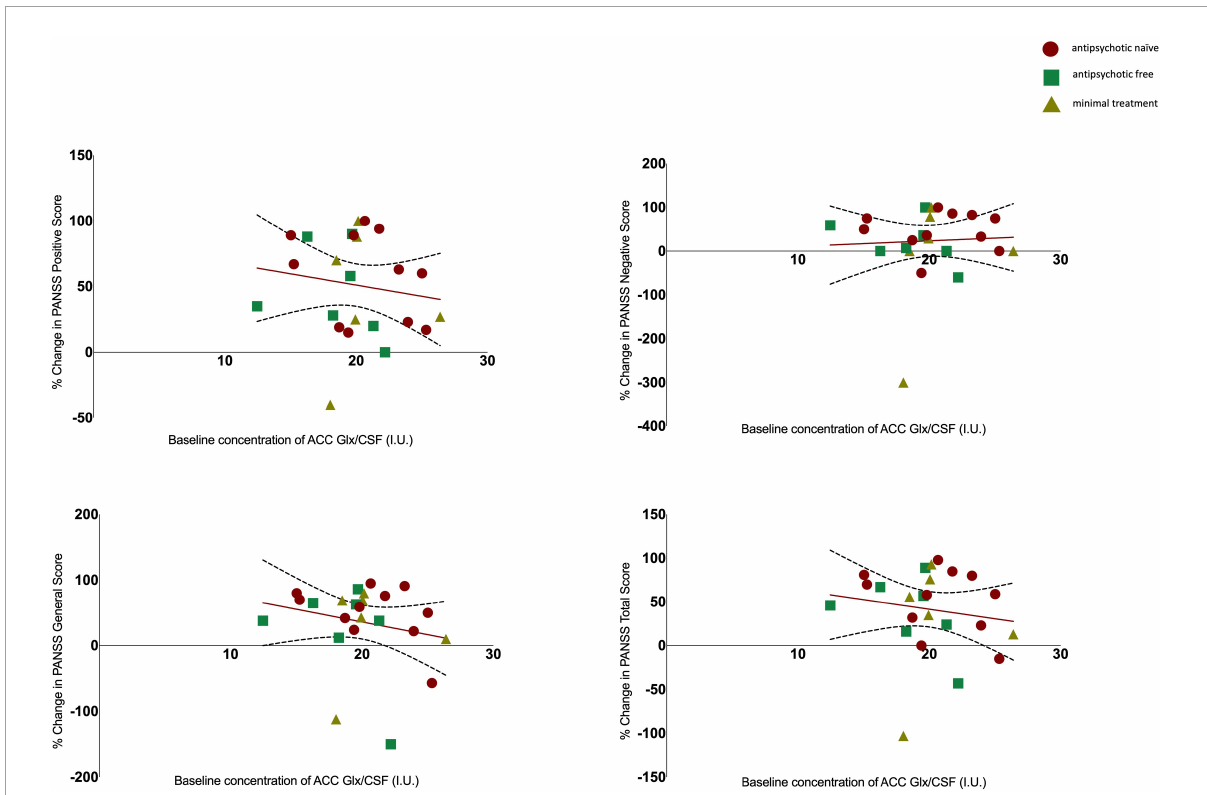
FIGURE3 Relationship between Glx levels and the percentage change in PANSS positive ( r = − 0.152, p = 0.477), negative ( r = 0.052, p = 0.811), general ( r = − 0.212, p = 0.320) and total scores ( r = − 0.155, p = 0.470) with 95% confidence intervals derived from the line of best fit. Individuals are stratified by medication status, antipsychotic naïve (circle), antipsychotic free (square), minimal treatment